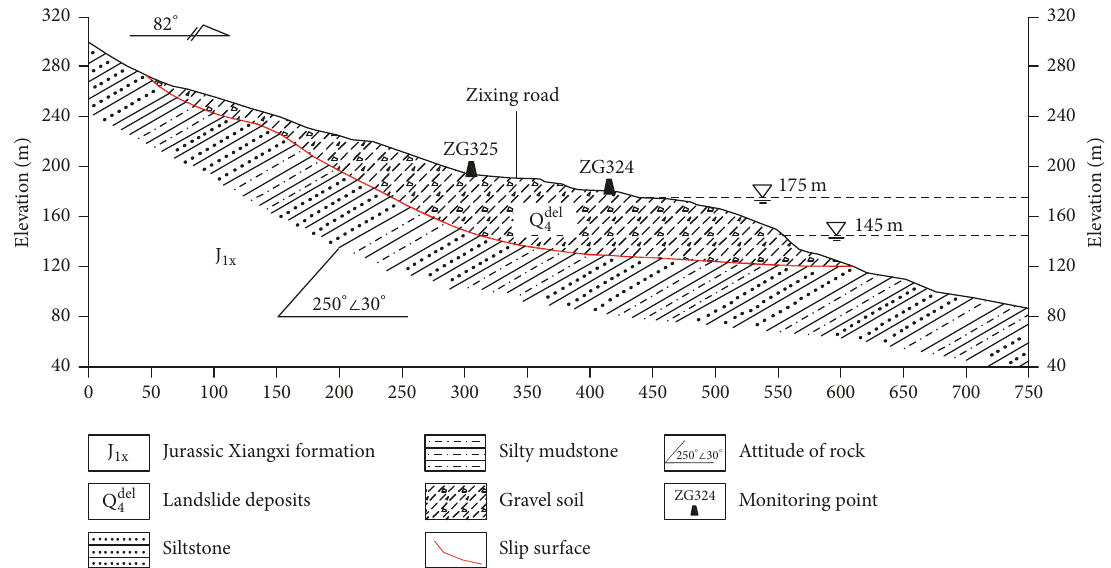
Figure 2: Geological cross-section (A-A 󸀠 ) of the Baijiabao